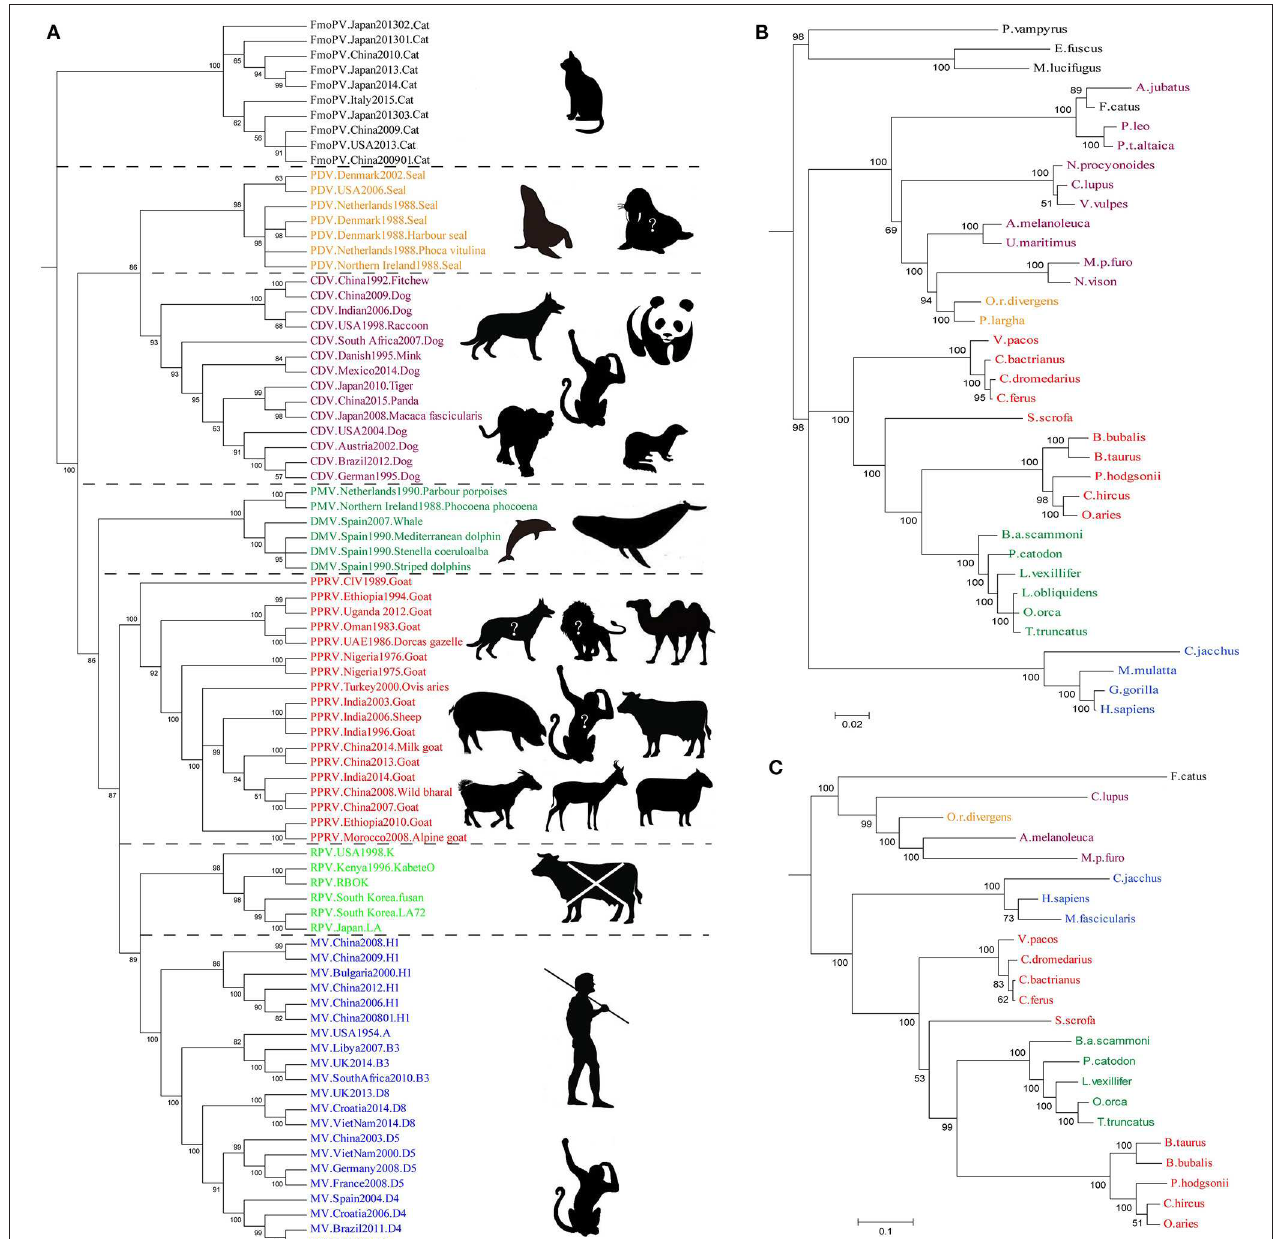
FIGURE 2 | The Bayesian Phylogenetic tree was constructed based on Morbillivirus Hemagglutinin and its receptors SLAM and Nectin-4 gene. (A) The genetic relationship of MV and PPRV was the closest of morbilliviruses, and PDV and CDV were located on the same evolutionary branch. The genetic relationship of FmoPV and the other morbilliviruses was highly distant. In the right side of the tree, the host or suspicious host exhibits a broad host range of the viruses. The animals tagged with “?” represent potentially infected hosts. (B,C) Phylogenetic tree of SLAM and Nectin-4. The evolutionary tree shows that the evolution of the H seems to be strongly associated with the evolution of the SLAM and Nectin-4 receptor, especially in the Nectin-4. The sequences which are used to construct the Bayesian Phylogenetic tree GenBank accession numbers are listed in Table 2